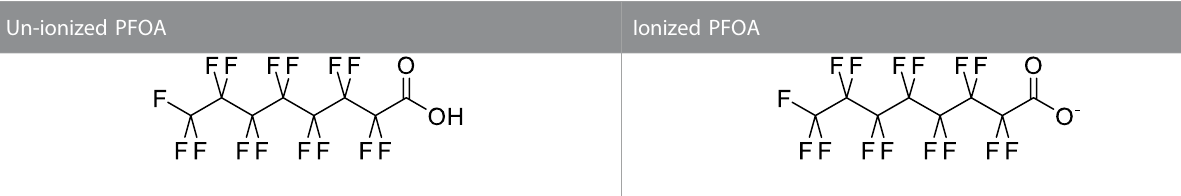
TABLE 3 Ionization states of per fl uorooctanoic